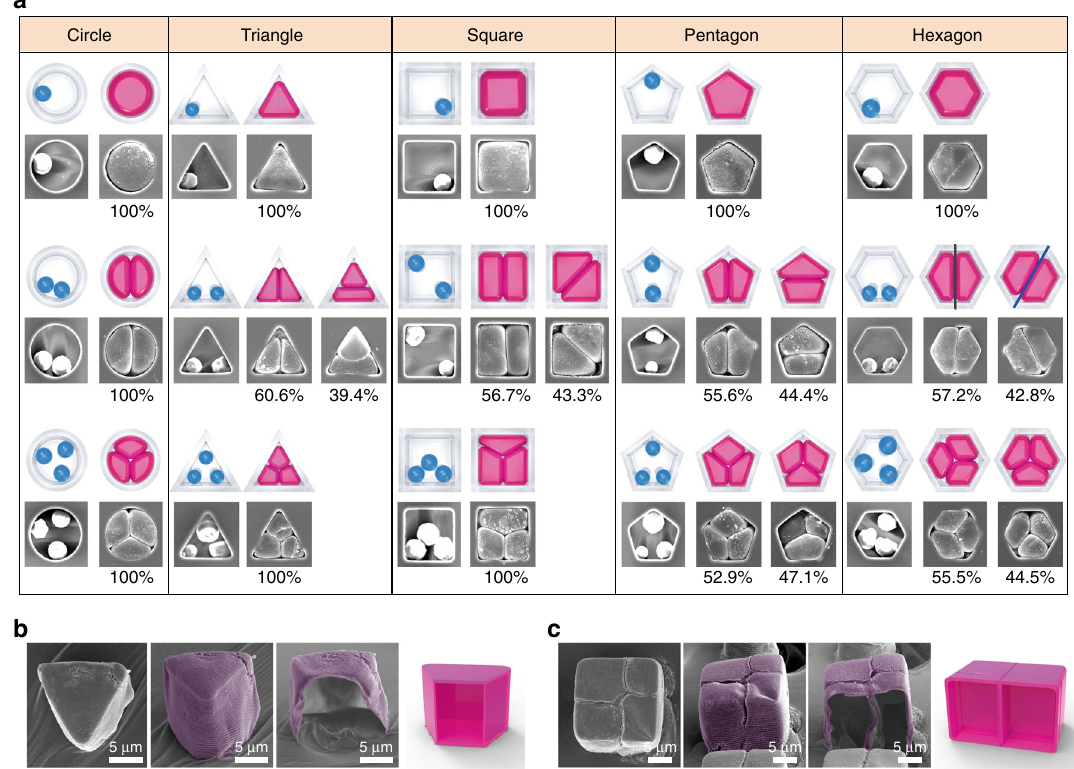
Fig. 5 A library of topographic clusters. a SEM images of the clusters and the corresponding illustrations. The number of cleavages of each cell corresponds to the number of the initial seeds. b , c Close-up SEM images of the triangular prisms ( b ) and four-cell cubes ( c ). The last image of each group shows the cavity within the clusters, for which they were cut by the FIB